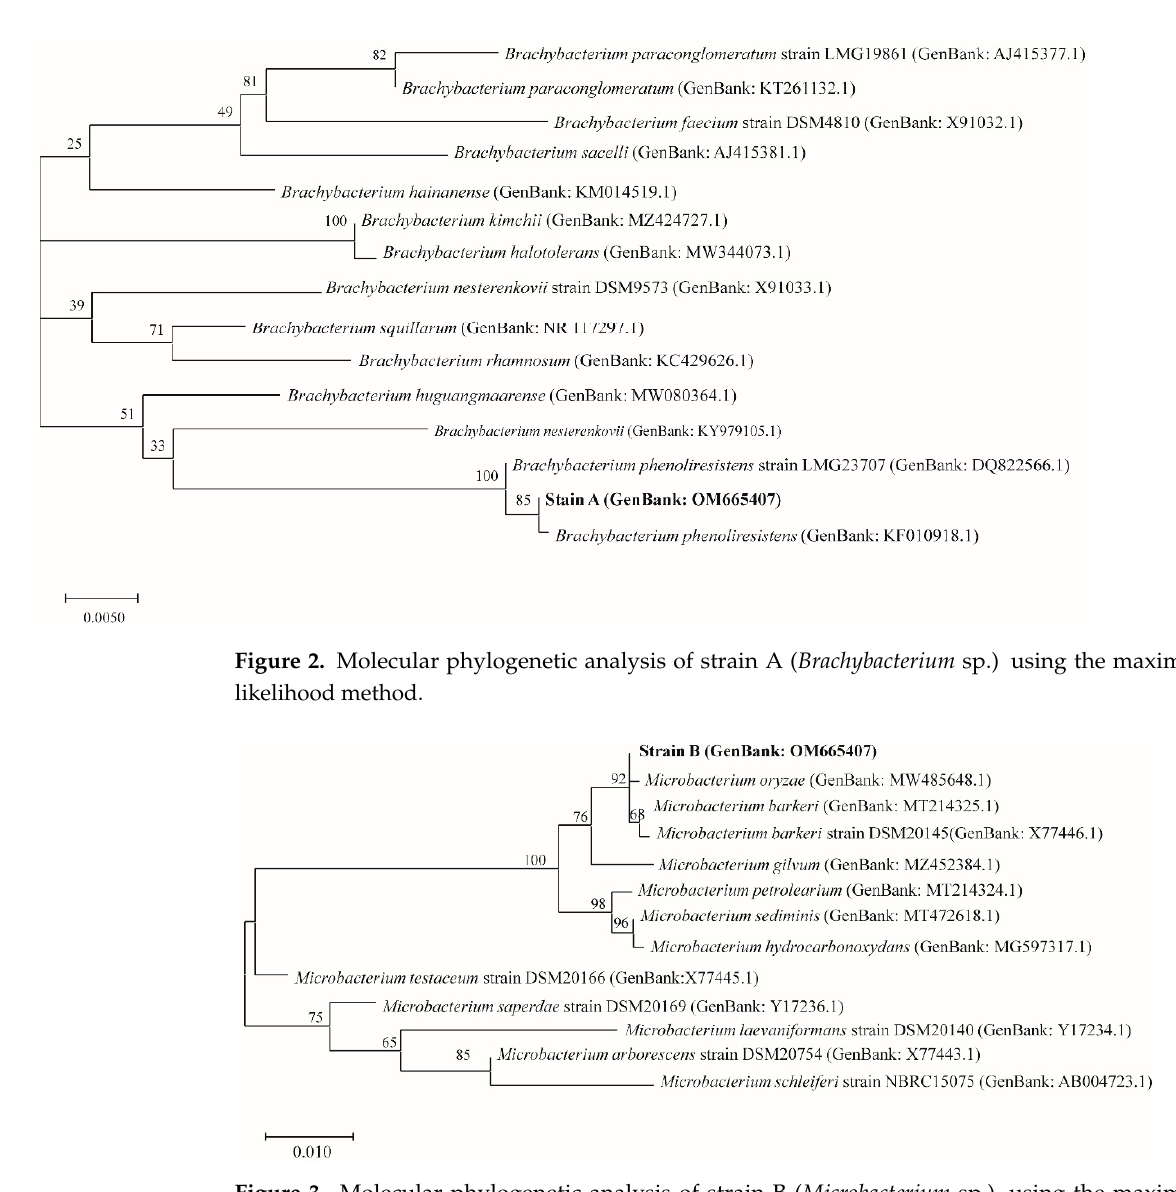
Figure 3. Molecular phylogenetic analysis of strain B ( Microbacterium sp . ) using the maximum likelihood method.